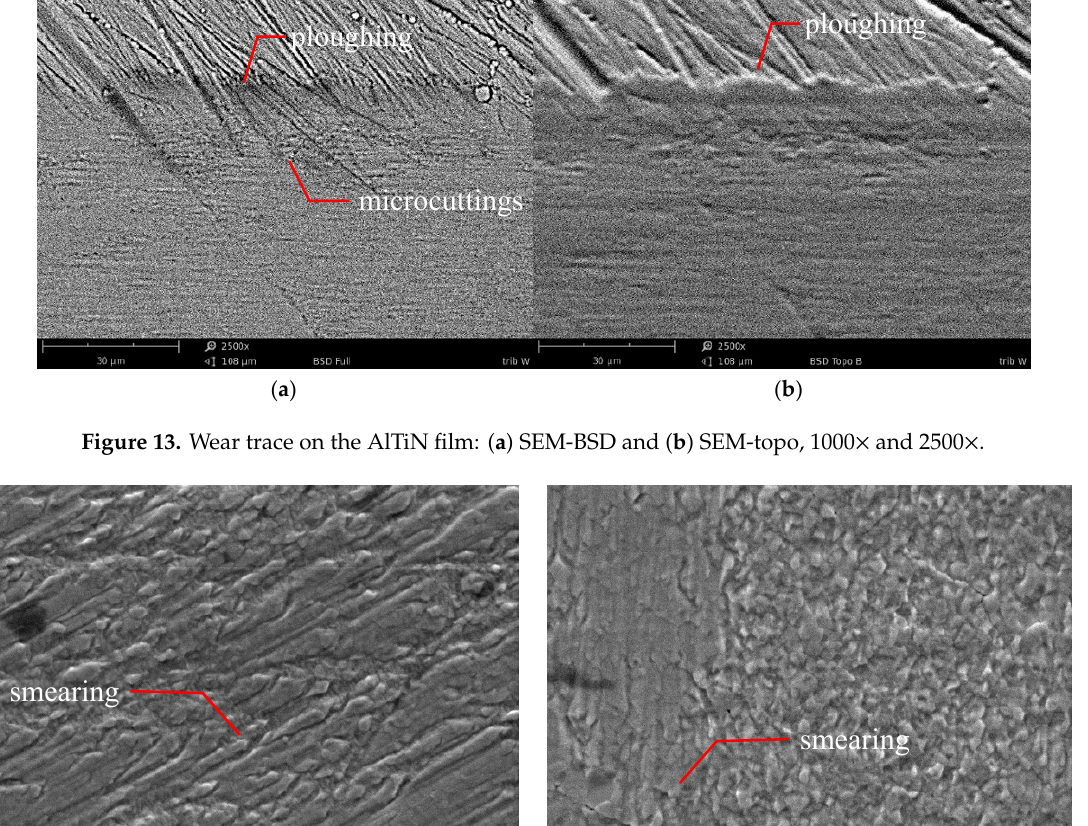
Figure 14. Sliding wear trace: ( a ) TiAlN; SEM, 15000x. and (b) AlTiN; SEM, 17000x.